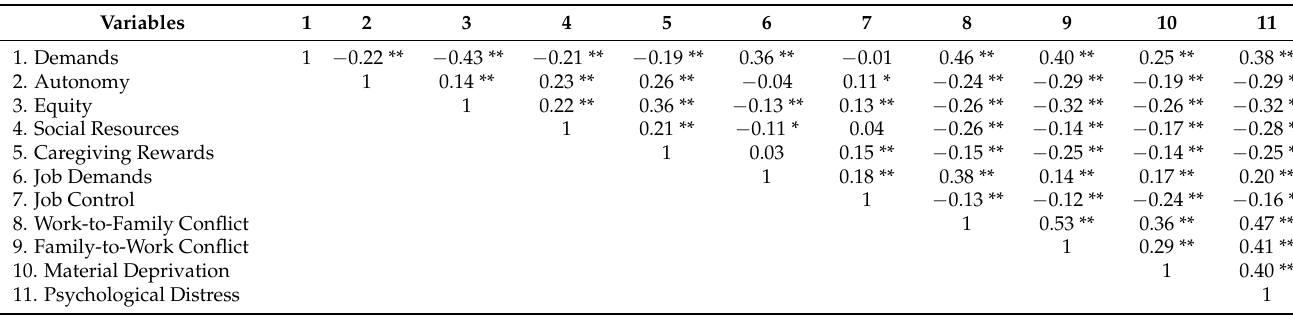
Table 2. Correlations among key variables ( n =